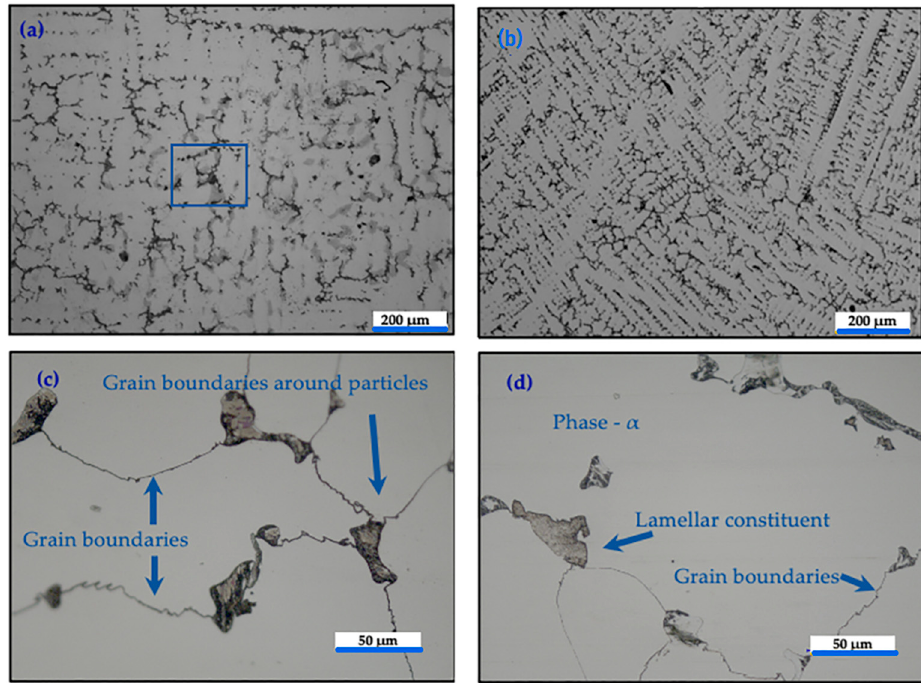
Figure 7. Optical microscopy images with two distinct scale bar 200 µ m and 50 µ m of the microstructure of the Co-Cr-Mo alloy: ( a ) cobalt-rich matrix phase, in blue square emphasis (AM1, no frequency applied); ( b ) abundance of M 23 C 6 carbides (AM2, 15 Hz); ( c ) carbides formed at grain boundaries and thin grain contour lines (AM3, 75 Hz); ( d ) lamellar carbides phases at grain boundaries (AM4, 150 Hz).